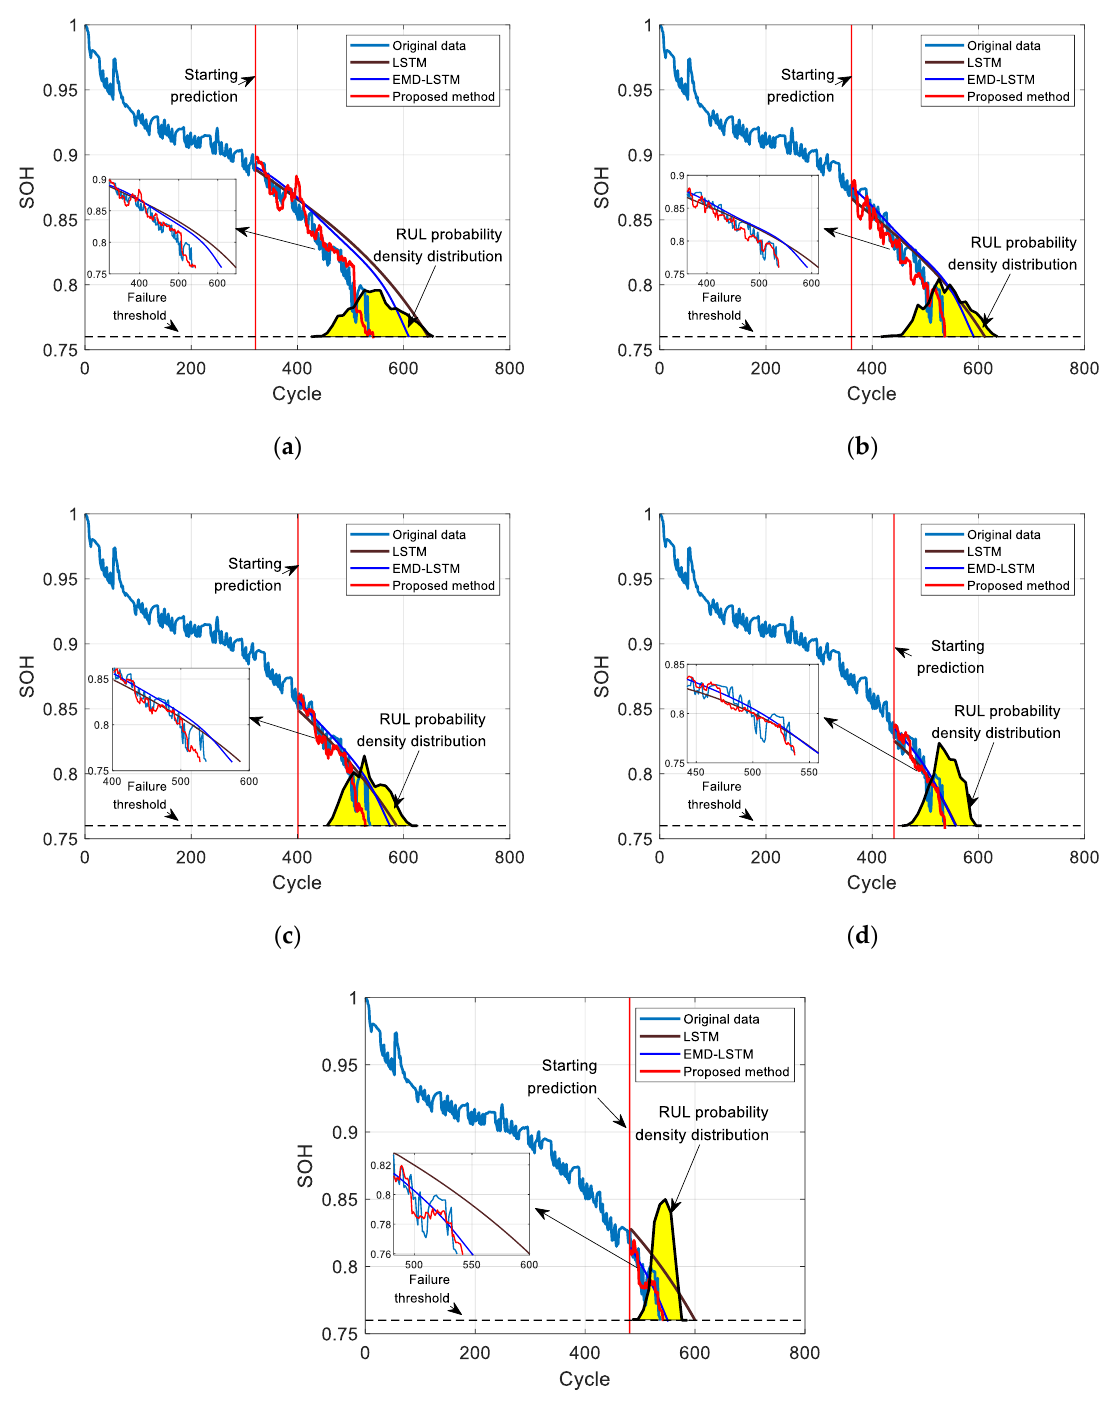
Figure 9. Comparison chart of the predicted remaining useful life of CS2_36 under different cycles: ( a ) 321 cycles, ( b ) 361 cycles, ( c ) 401 cycles, ( d ) 441 cycles, ( e ) 481 cycles.